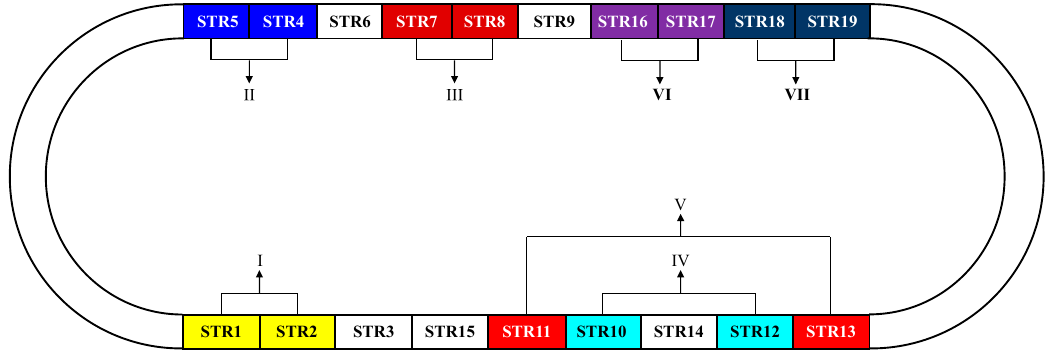
Figure 1. The RIOHTrack layout.